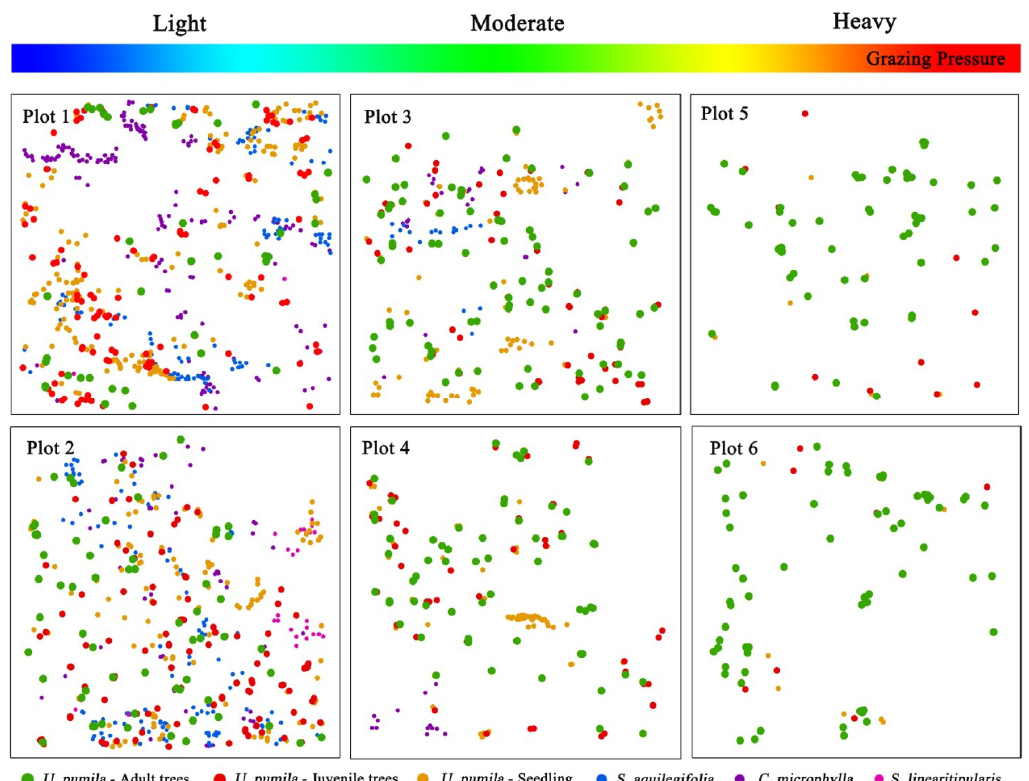
Figure 2. Spatial distribution of the main woody plants in the different grazing plots.